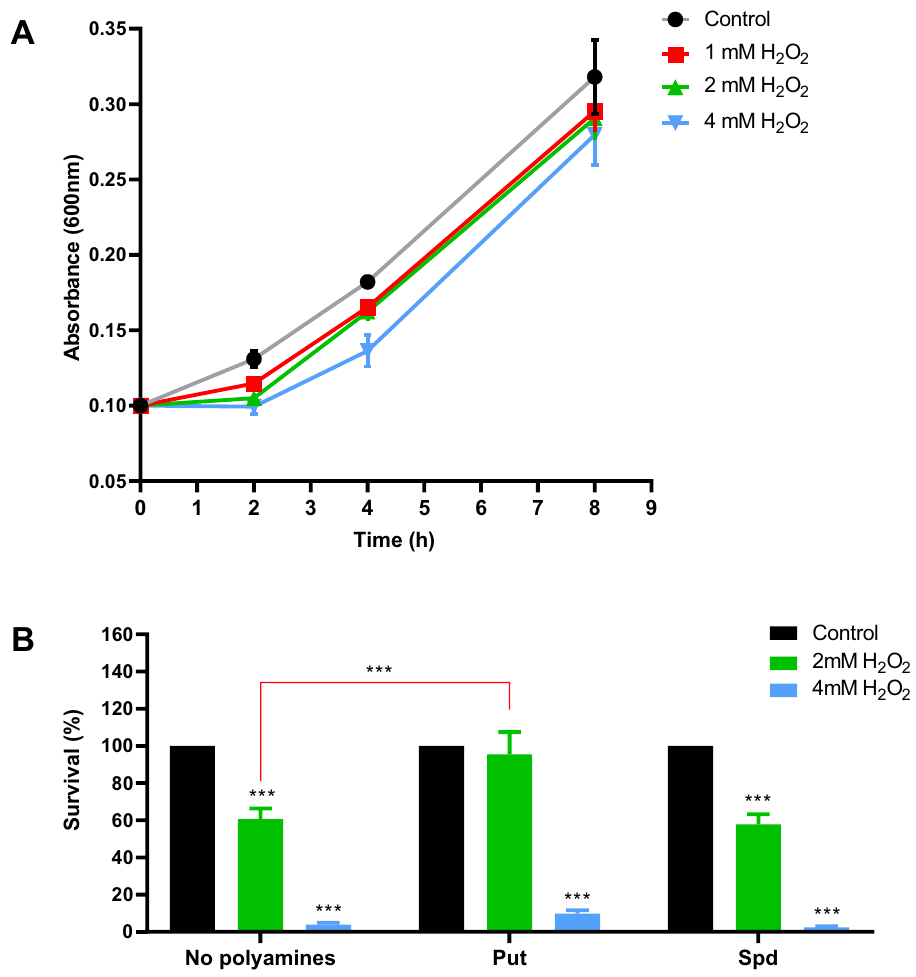
Figure 1. ( A ) Effect of H 2 O 2 on bacterial growth. Pst DC3000 was grown in M9 under control condition or with the amendment of H 2 O 2 at the indicated concentrations. Growth was followed by the determination of the absorbance of cultures at 600 nm. ( B ) Cell survival in the presence of H 2 O 2 . Pst DC3000 cultures in M9 (initial OD 600 = 0.2) were incubated for 1 h in under control conditions or in the presence of 2 or 4 mM H 2 O 2 either without or with Put or Spd supplementation at a final concentration of 2 mM. After this period, CFUs were determined and expressed as a percentage of the values quantified in control cultures (black bars). Statistically significant differences were evaluated by one-way ANOVA followed by Tukey´s multiple comparison tests. Asterisks on top of bars indicate differences between controls and H 2 O 2 -treated cells. Statistical differences between polyamine-treated cells are indicated with red square brackets. ***p <